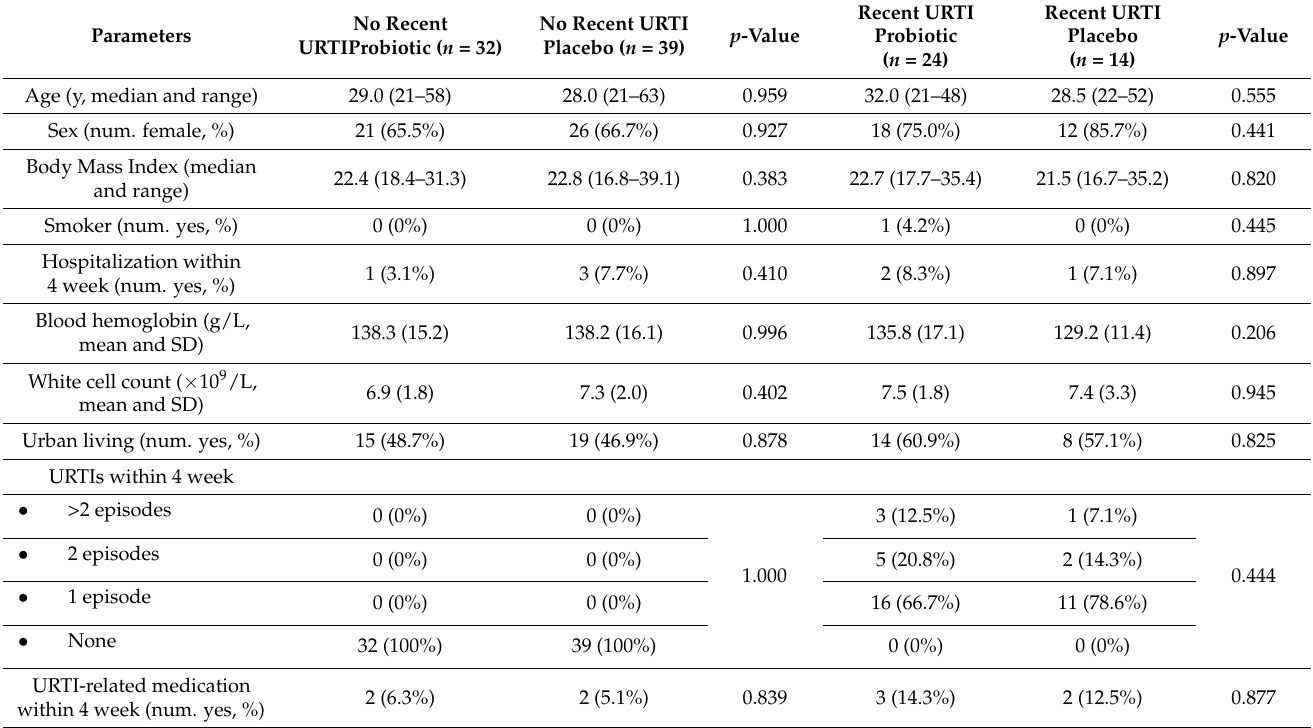
Table A2. Baseline characteristics of the study population (Probiotic n = 56, Placebo n = 53), split by history of recent URTI (presence or absence of URTI within past 4 weeks). No significant differences were noted between interventions within each